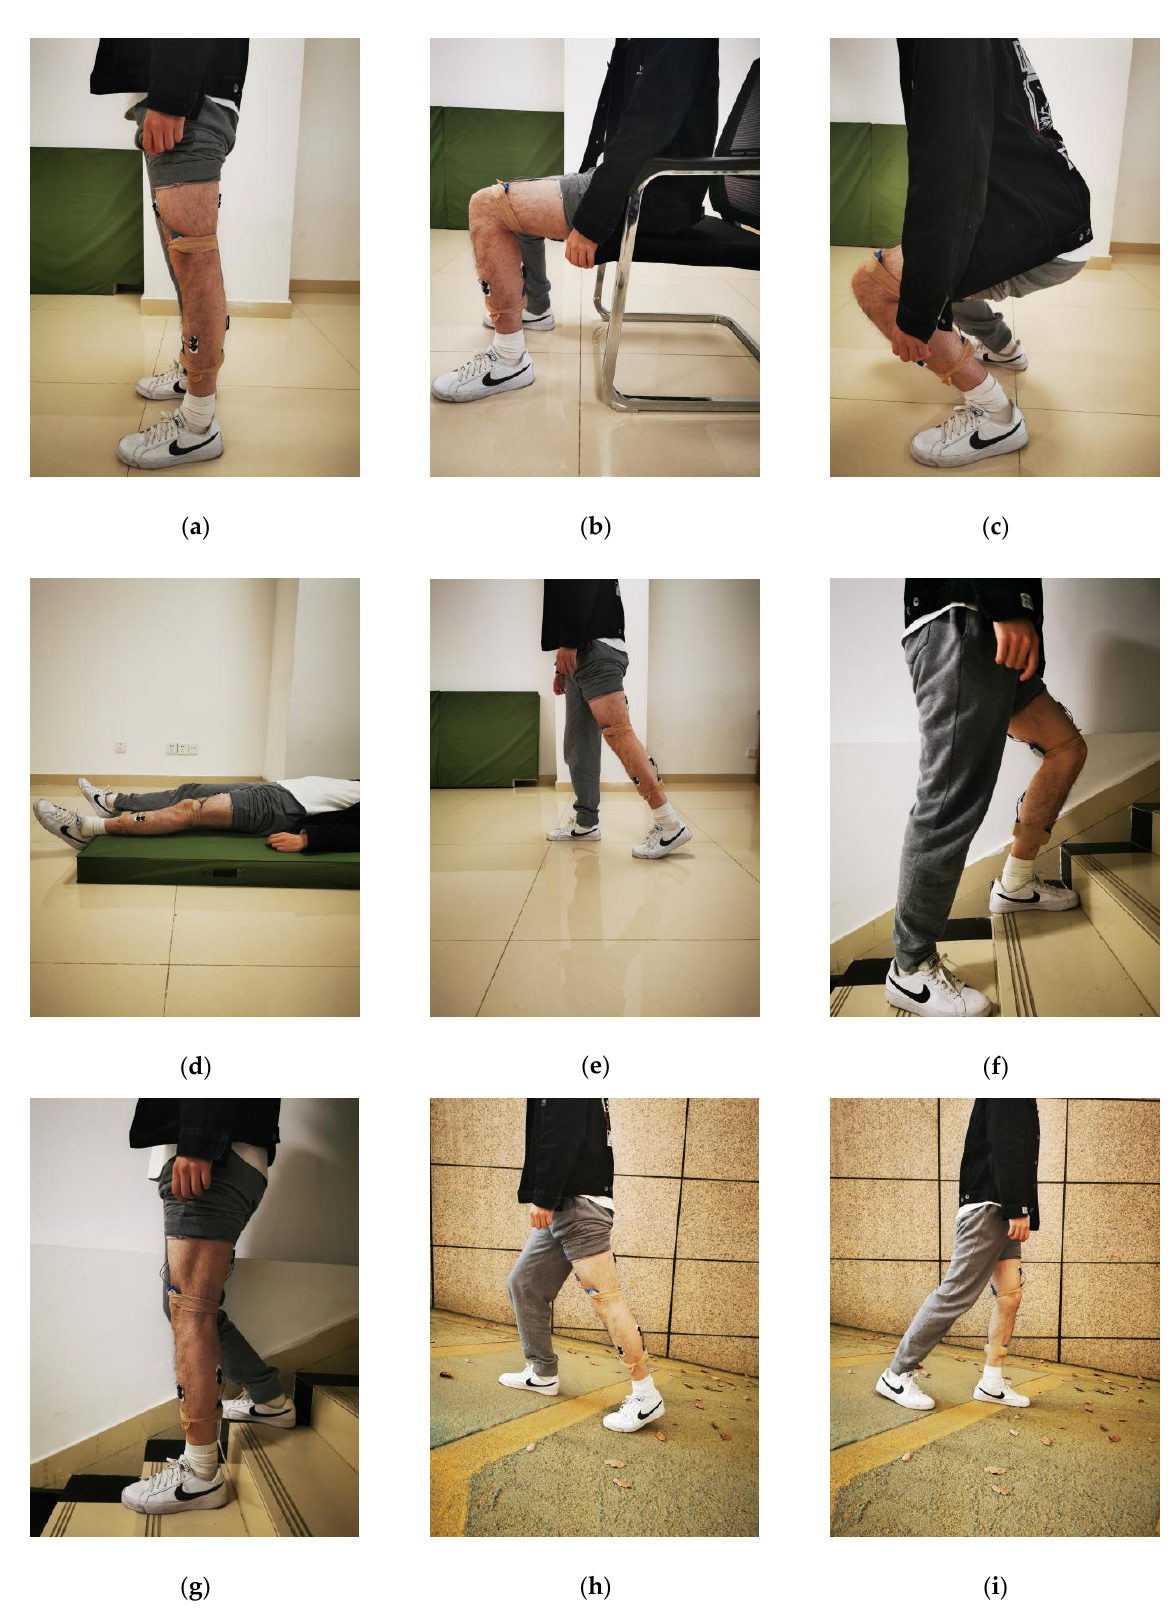
Figure 5. The selected ADLs: ( a ) standing, ( b ) sitting, ( c ) squatting, ( d ) lying, ( e ) walking, ( f ) ascending stairs, ( g ) descending stairs, ( h ) ascending ramps, and ( i ) descending ramps.